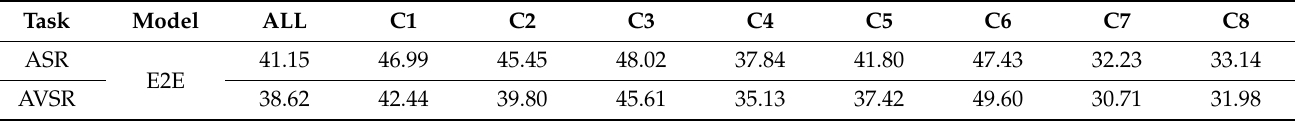
Table 5. The comparison of ASR-E2E and AVSR-E2E under the same pre-training strategy and training data. For the pre-training strategy, we use the ‘HS (CAT)’ method. For the training data, we used the ‘CAT’ method.